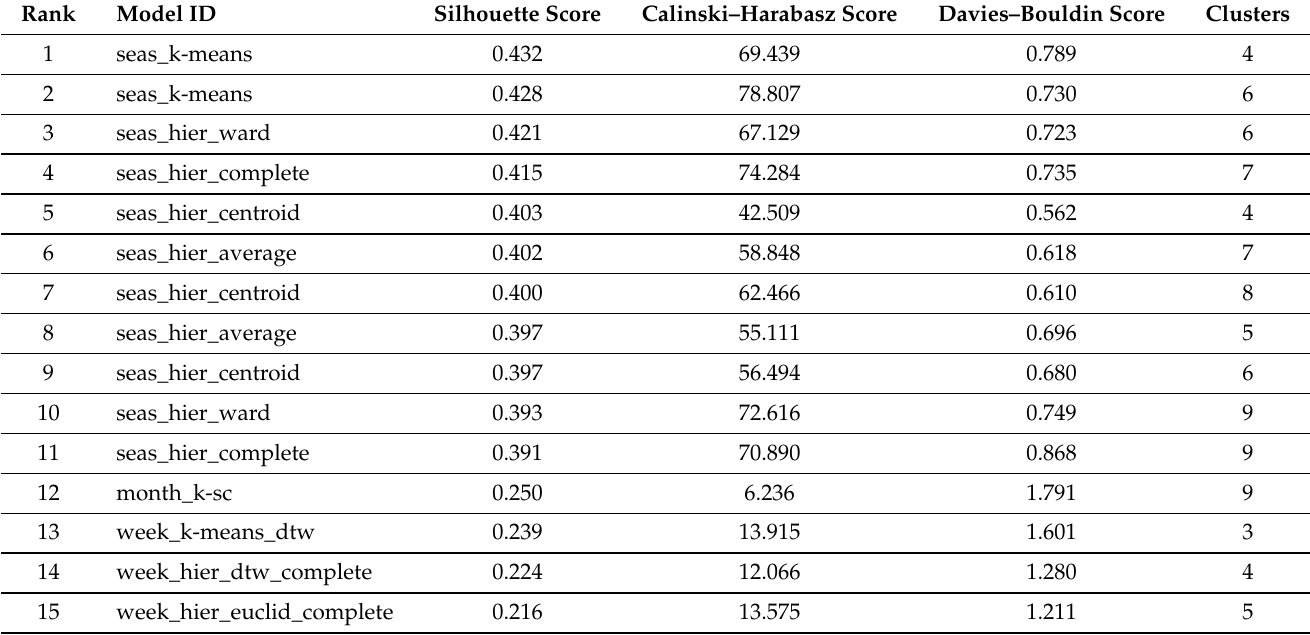
Table 4. Ranking of the 15 best models according to the Silhouette